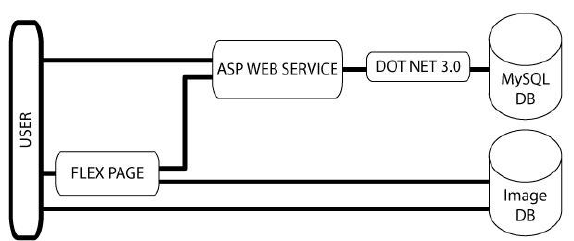
Figure 3: ArcRange component diagram